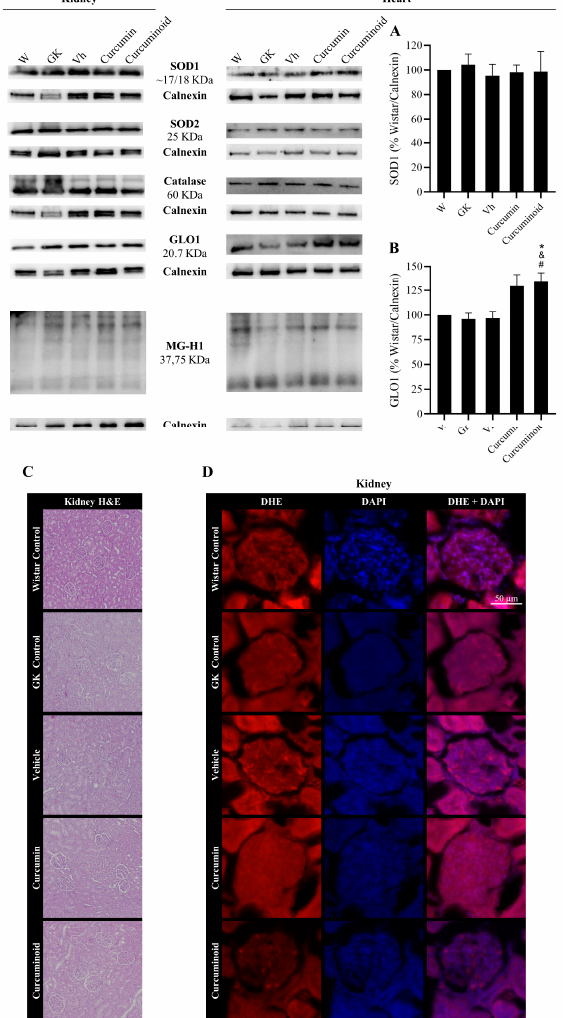
Figure 6. Improved content of the antioxidant enzyme GLO1 ( B ) in the heart after treatment with the curcuminoid, calculated as percentage of Wistar control/Calnexin, assessed by WB; representative WB is shown. SOD1 ( A ) levels were also evaluated in heart by WB. Histological analysis shows hematoxylin–eosin (H&E) staining in kidney ( C ). Oxidative stress was evaluated in the kidney though the determination of the superoxide generation by the DHE dye. Representative kidney sections showing DHE staining (red) ( D ). W: Wistar control; GK: Goto-Kakizaki control; Vh: Goto-Kakizaki submitted to vehicle (DMSO) administration; Curcumin: Goto-Kakizaki submitted to curcumin administration (40 mg/Kg/day, s.c.) and Curcuminoid: Goto-Kakizaki submitted to curcuminoid (52.4 mg/Kg/day, s.c.) administration. Results are expressed as mean ± S.E.M.; vertical bars represent S.E.M.; n = 5–9/group; statistical differences were evaluated by Tukey’s test. * vs. W; & vs. GK; # vs. Vh. 1 symbol p <